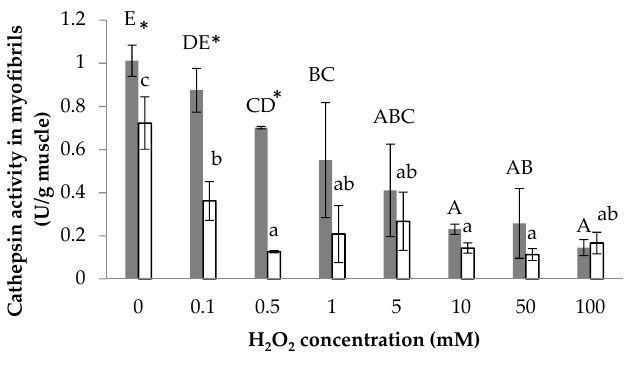
Figure 1. Cathepsin L and cathepsin B activities from bighead carp myofibrils under different H 2 O 2 concentrations. The same lowercase letter indicates no significant differences between cathepsin B activities under different H 2 O 2 concentrations. The same capital letter indicates no significant differences between cathepsin L activities under different H 2 O 2 concentrations. The asterisk indicates significant difference between cathepsin L and cathepsin B activities under the same H 2 O 2 concentration ( p < 0.05).